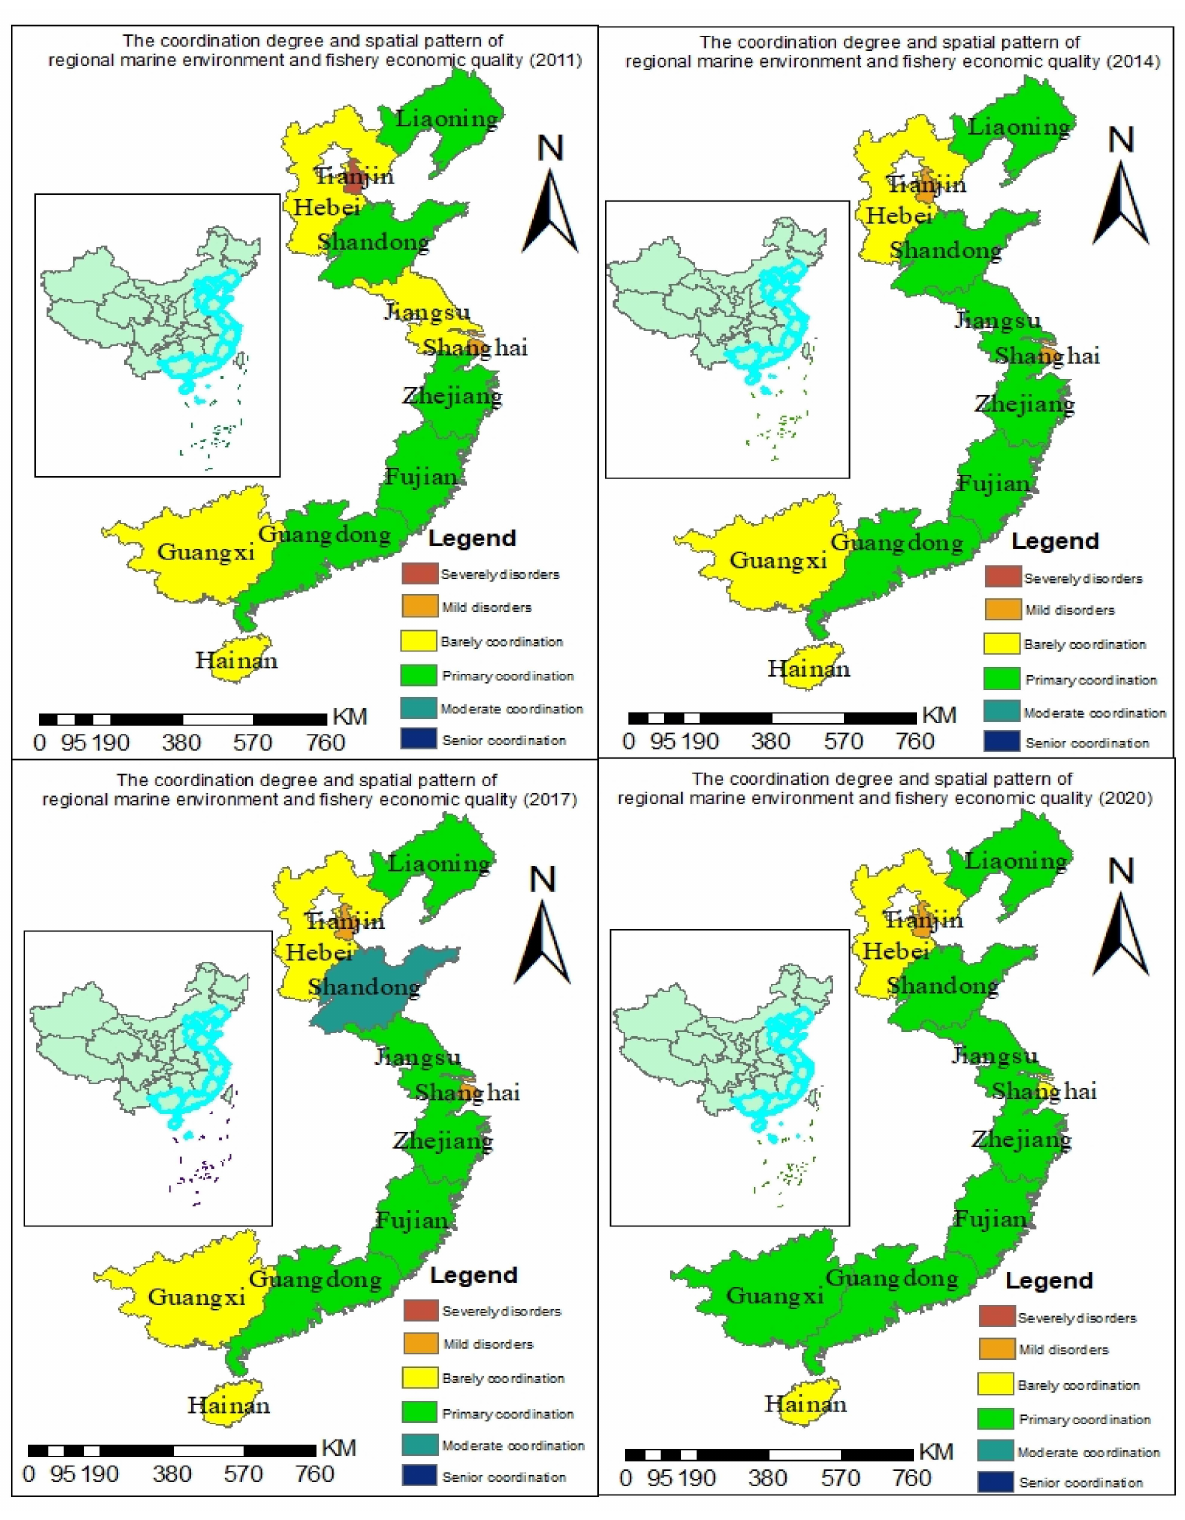
Figure 4. Spatial patterns of coordination between marine-environment quality and marine-fishery- economy quality in typical